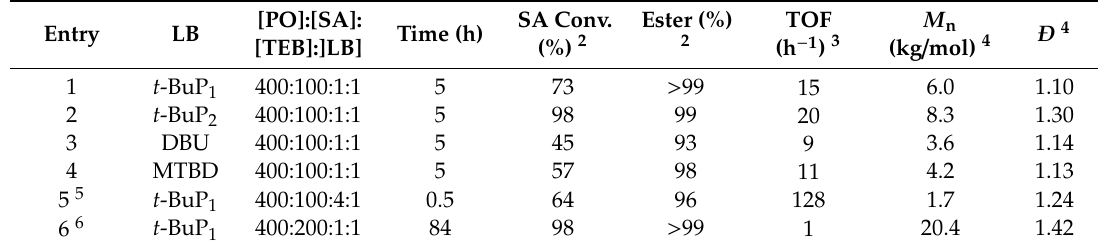
Table 2. SA / PO copolymerization catalyzed by various LBs with TEB 1